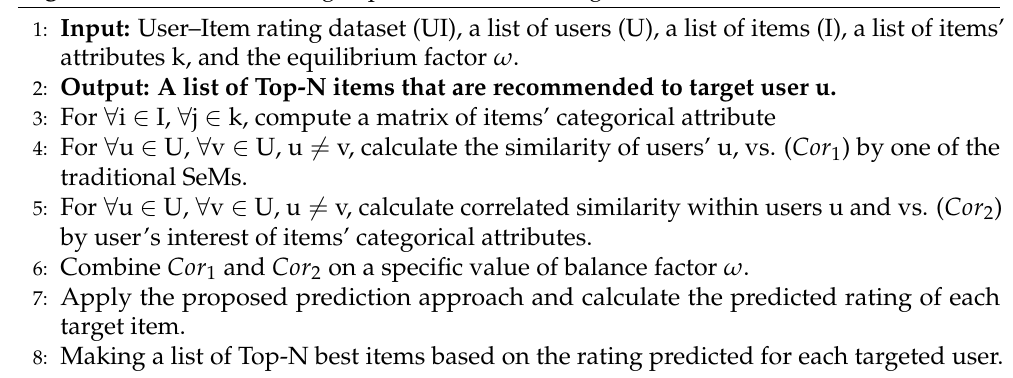
Algorithm 1 Recommending Top-N Items to the Target